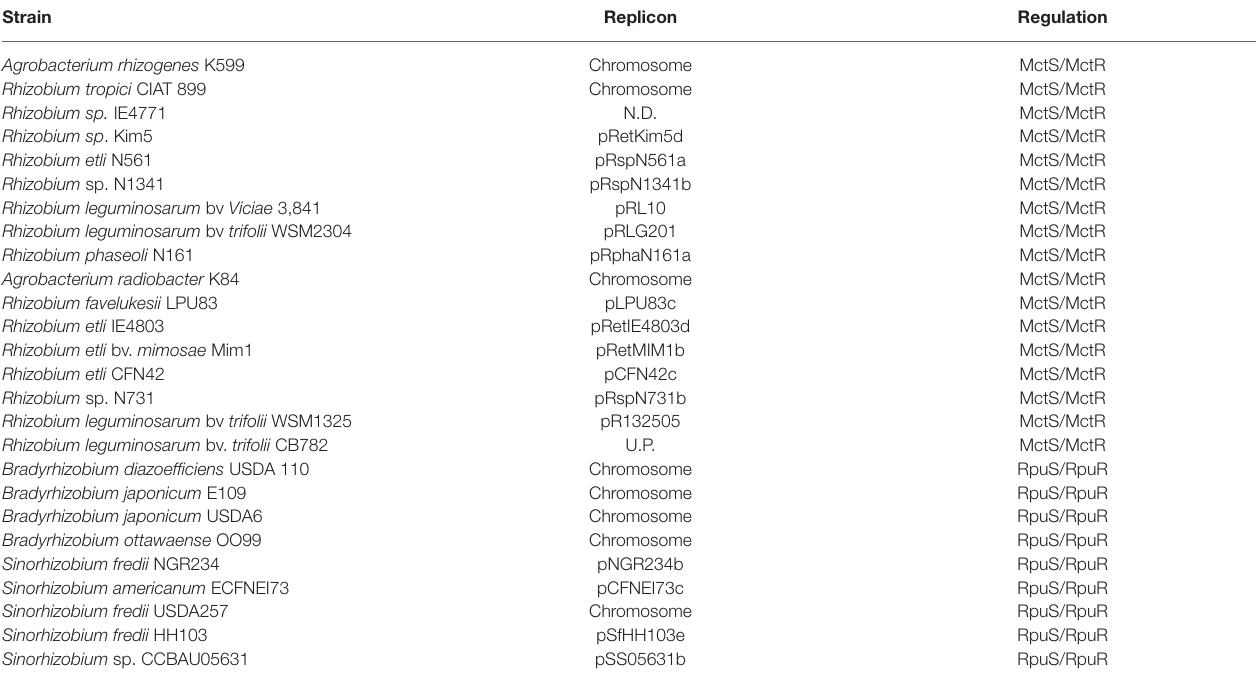
TABLE 3 | Rhizobia with mctP neighbored by a